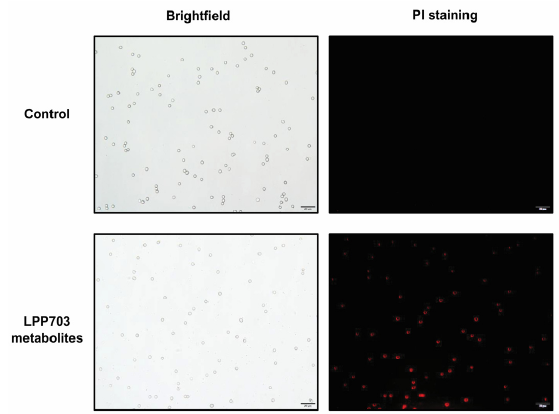
Figure 3. Effect of metabolites produced by the Lactiplantibacillus plantarum LPP703 strain on the cell membrane integrity of Penicillium sp. Scale bar, 20 μ m.